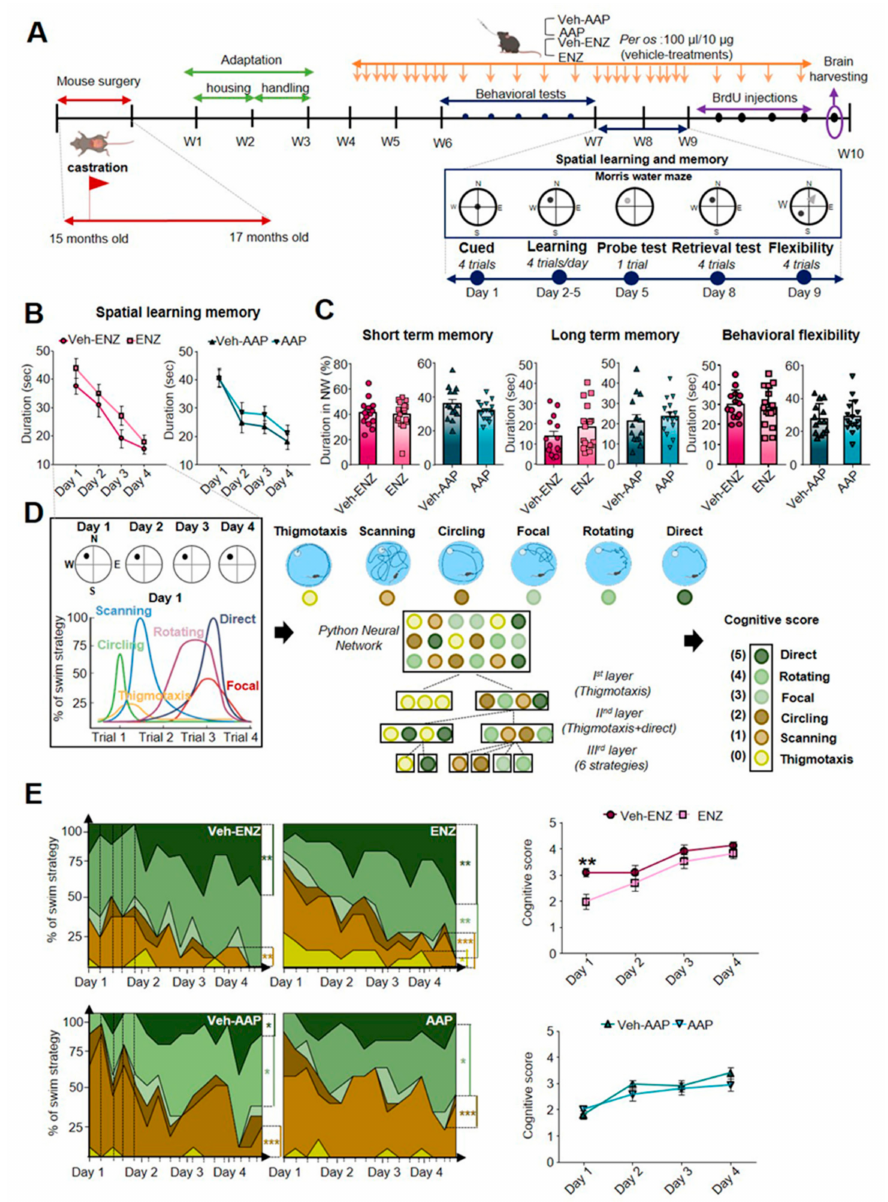
Figure 6. ENZ and not AAP specifically alters spatial learning efficiency and cognitive score. Note. ( A ) In vivo experimental time course of treatment delivery and learning and memory cognitive evaluation by Morris water maze test (MWM). MWM was performed for 7 days starting from W7 (blue arrow) with familiarization (cued) on D1, the learning phase from D2 to D5, the probe test two hours after learning trials on D5, the retrieval test on D8 and the flexibility analyzed on D9 during treatments as indicated (orange arrows). Then for 4 days mice received one BrdU injection per day (50 mg/kg) before sacrifice, brain were harvested for immunohistochemical analyses (purple arrow) and plasma were sampled. ( B ) Cognitive consequences of ENZ or AAP treatment compared with a vehicle on spatial learning. Bar scatter plots showing the time to reach the platform (escape